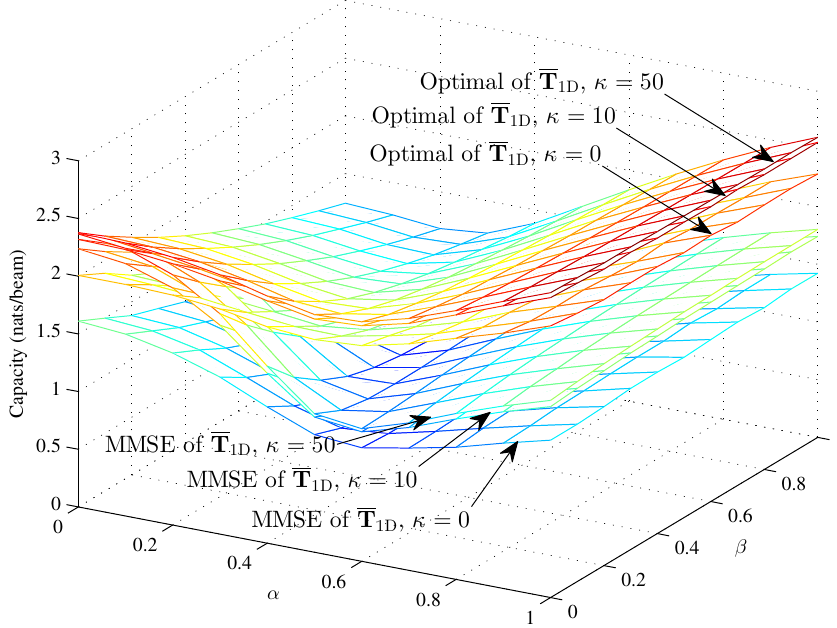
Figure 4. The optimal capacity and MMSE capacity of the hybrid 1D beams with γ = 10 and N = 100 ( κ = 0, κ = 10 and κ = 50) versus α and β